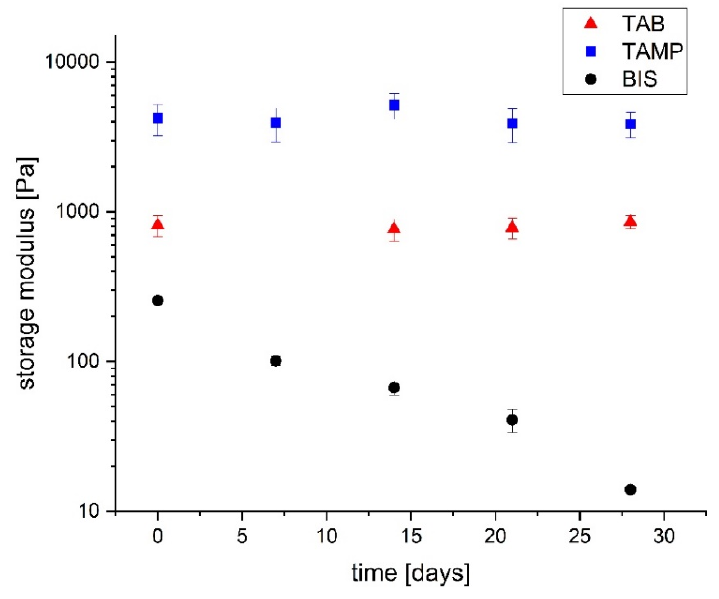
Figure 7. Change of the storage moduli of poly(DADMAOH- co -MAA)-hydrogels crosslinked with 2 mol% TAAB (triangles) or TAMPB (squares) and 4 mol% BIS (circles) at 60 ◦ C. Over the course of 28 days at 60 ◦ C, the storage modulus of the BIS-crosslinked samples continuously decreased from 256 Pa to approx. 13 Pa. This enormous loss can the storage modulus of gels crosslinked with TAAB ( 1a ) or TAMPB ( 1c ) appeared to be